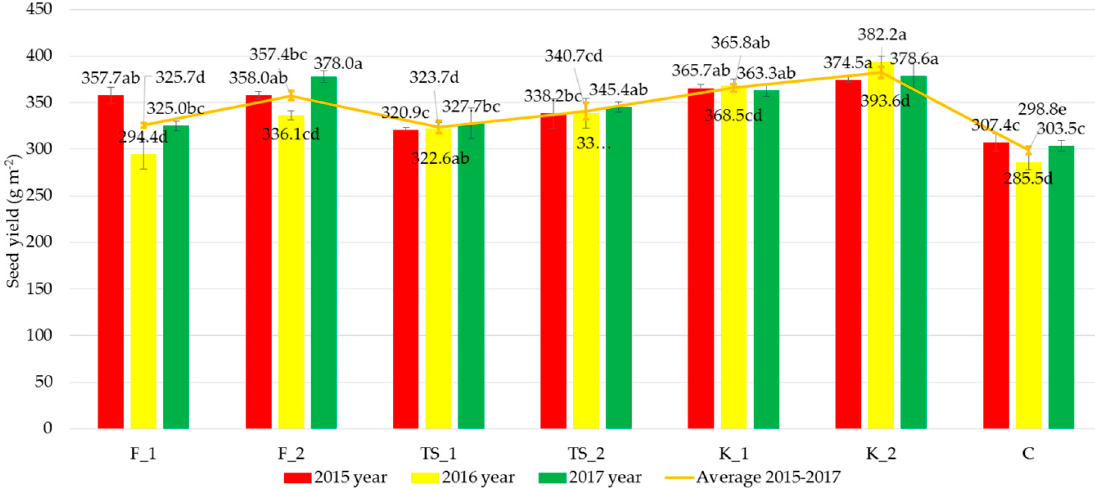
Figure 1. Effect of Fylloton, Terra Sorb Complex, and Kelpak biostimulant treatment on seed yield of bean variety Oczko. Abbreviations: F_1, single spraying of Fylloton; F_2, double spraying of Fylloton; TS_1, single spraying of Terra Sorb Complex; TS_2, double spraying of Terra Sorb Complex; K_1, single spraying of Kelpak; K_2, double spraying of Kelpak; C, control. Means over the study years followed by different small letters are significantly different at p < 0.05.